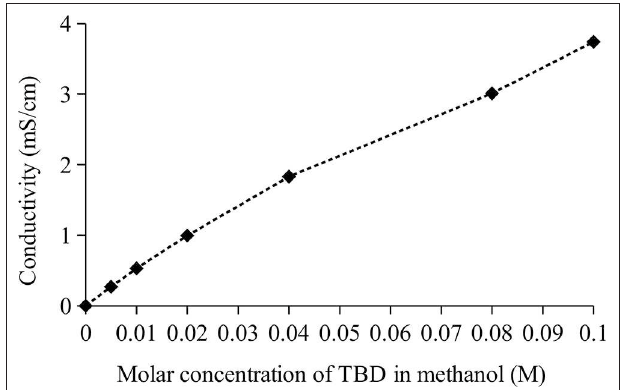
FIGURE 6 | Conductivity of methanol at different TBD guanidine molar concentrations.